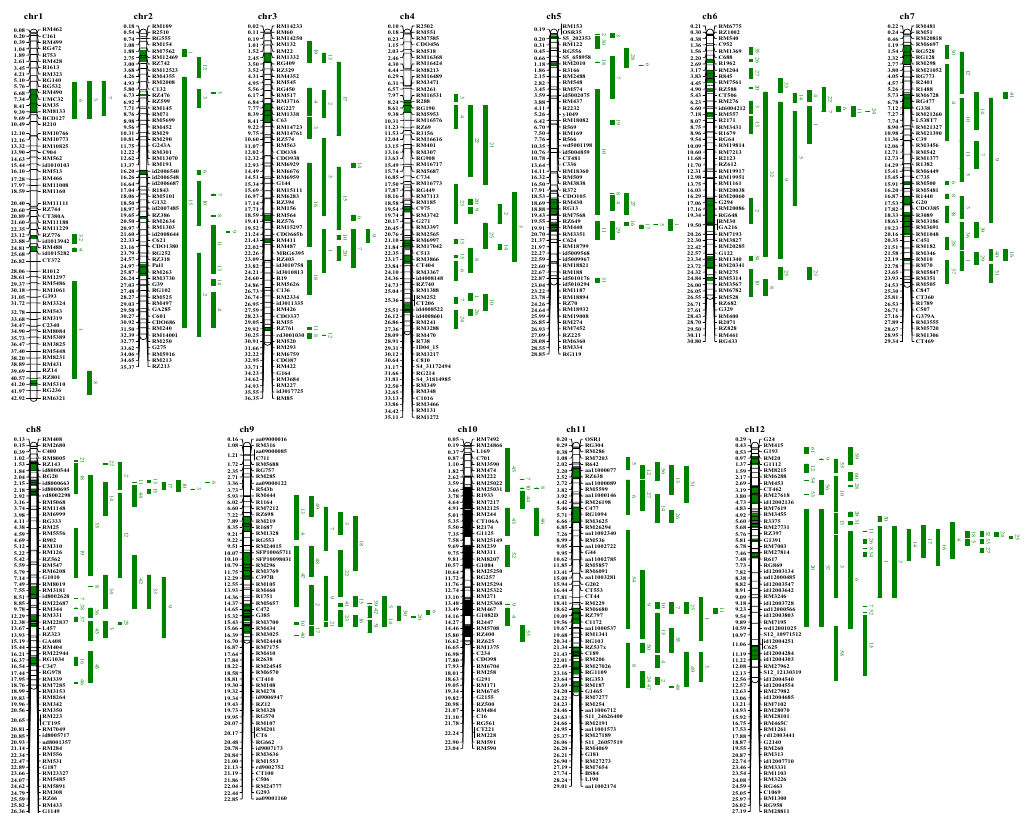
Figure 1. “Consensus” QTL map related to blast resistance in rice. Chr: chromosome; The bars represent the chromosomes; The molecular markers are located on the right of chromosomes, the physical distances of those in mega base (Mb) are located on the left of chromosomes; The original QTLs are positioned on the right of molecular markers in the “consensus” map; Fragments with green color represent confidence intervals of meta-QTLs in the